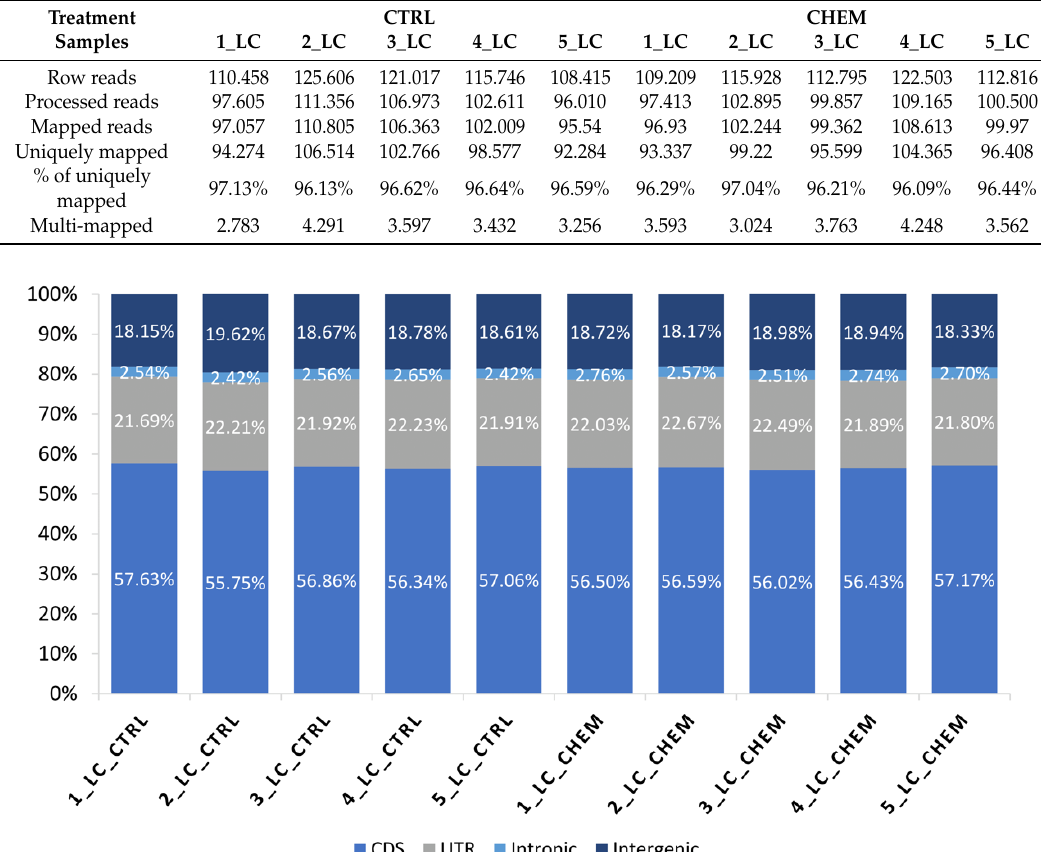
Table 2. Summary of the results of RNA sequencing, preprocessing and mapping of reads to the porcine reference genome. All numerical values are expressed in millions. CTRL are samples from control group, and CHEM are samples from chemerin-treated group.